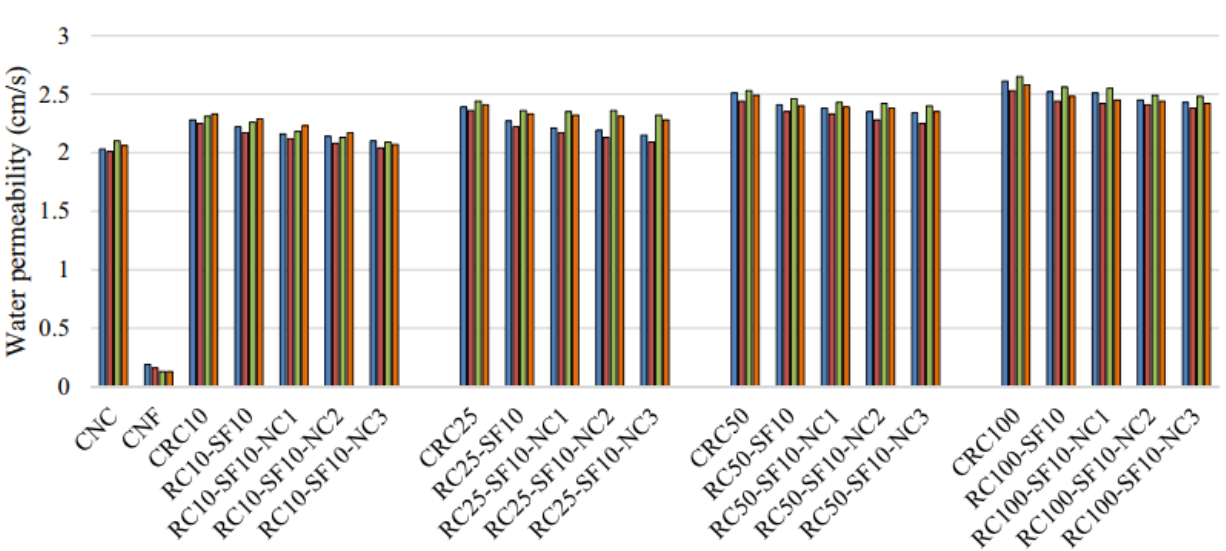
Figure 12. Influence of fiber content and type on the permeability to water [74]. STF: steel fiber; WPF: waste plastic fiber.